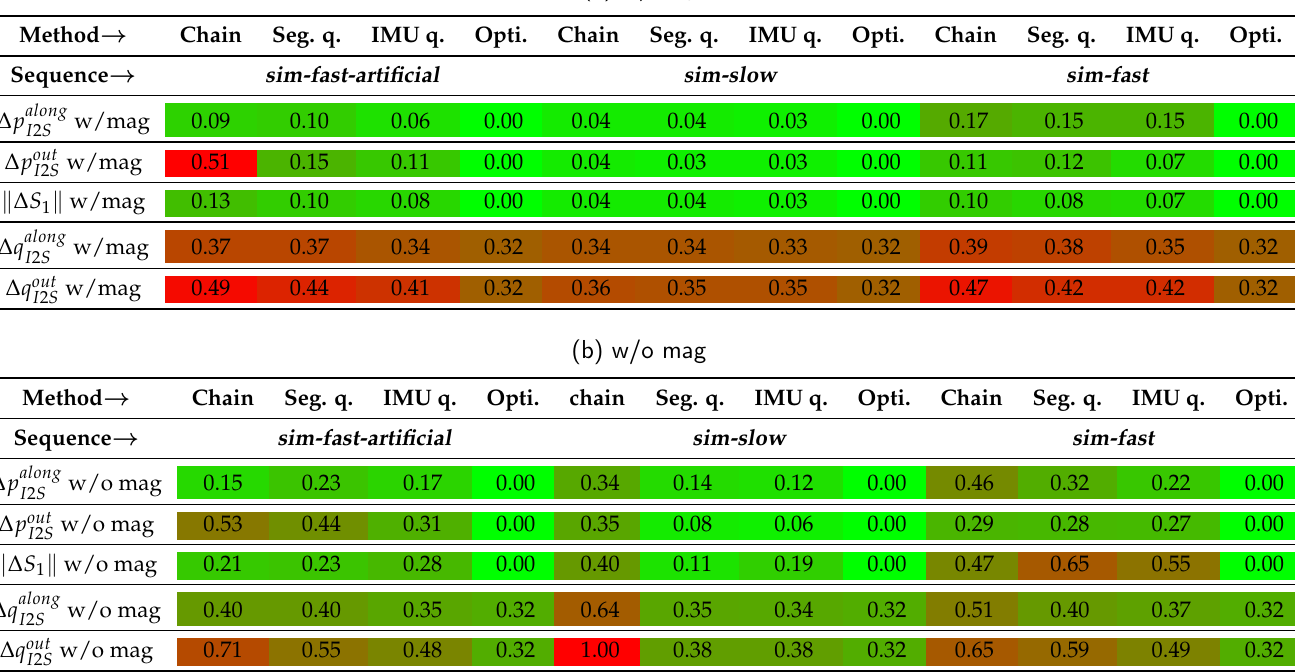
Table 8. Simulation scenario: the normalized range error E tracker (cf. Equation (23)) is shown for the different simulated model calibration errors and sensor fusion quot methods. The latter have the following shortcuts: Chaintracker (chain), Quattracker segment (Seg. q.), Quattracker IMU (IMU q.), Optitracker (opti.). Note, for each table separately, the color represents a linear interpolation of the error from red (maximum error) to green (minimum